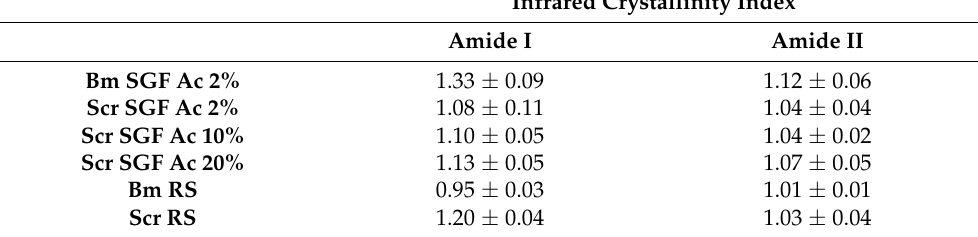
Table 1. Infrared crystallinity indices of silkworm gut fibres (SGF) produced from silk glands of S. c. ricini (Scr SGF) under different experimental conditions and from B. mori (Bm SGF), as well as those correspondent to raw silk fibroins produced by both species of silkworms (named as Scr RS and Bm RS, respectively). The values are calculated as the ratio between the measured absorbance at 1625 and 1650 cm − 1 (for the amide I peak) and between 1515 and 1538 cm − 1 (for the amide II peak). Expressed as average values ± standard